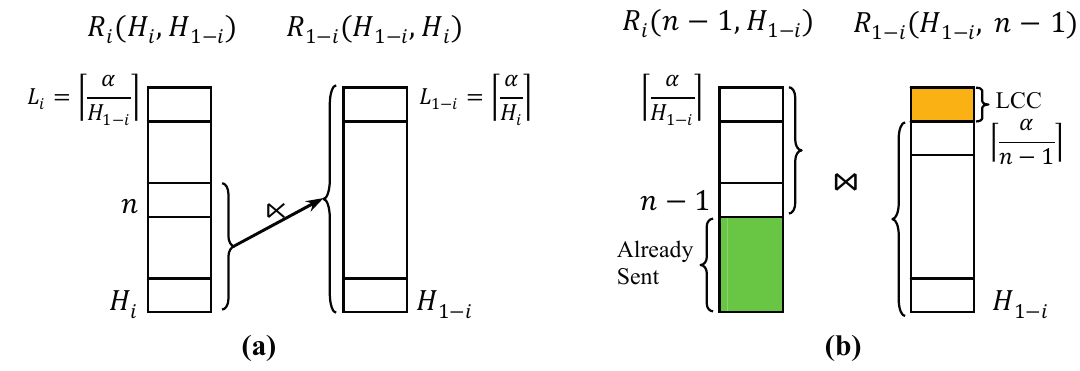
Figure 7. Algorithm for Generating Optimal Sequence of Fragment Semijoins.